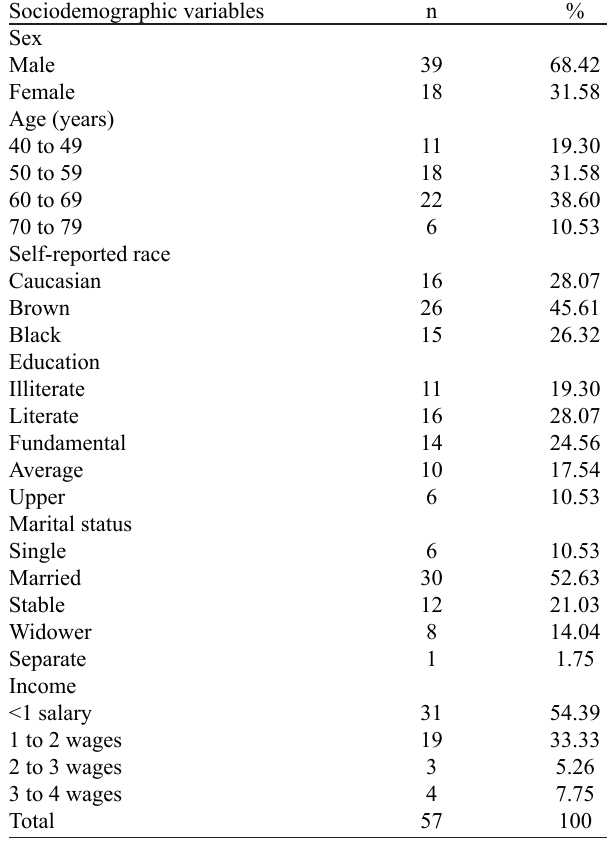
Table 1. Characterization sample of subjects undergoing CABG at different time points. São Luís - MA,